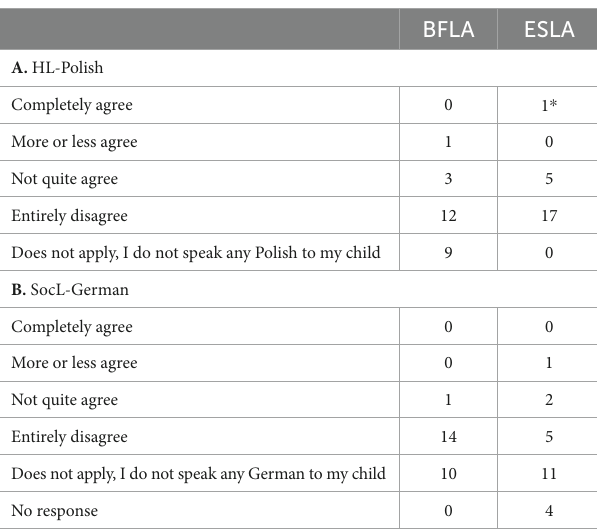
TABLE 3 Who filled out the BILTALK sub-questionnaire? TABLE 4 Comprehension misunderstandings: Number of parental responses per